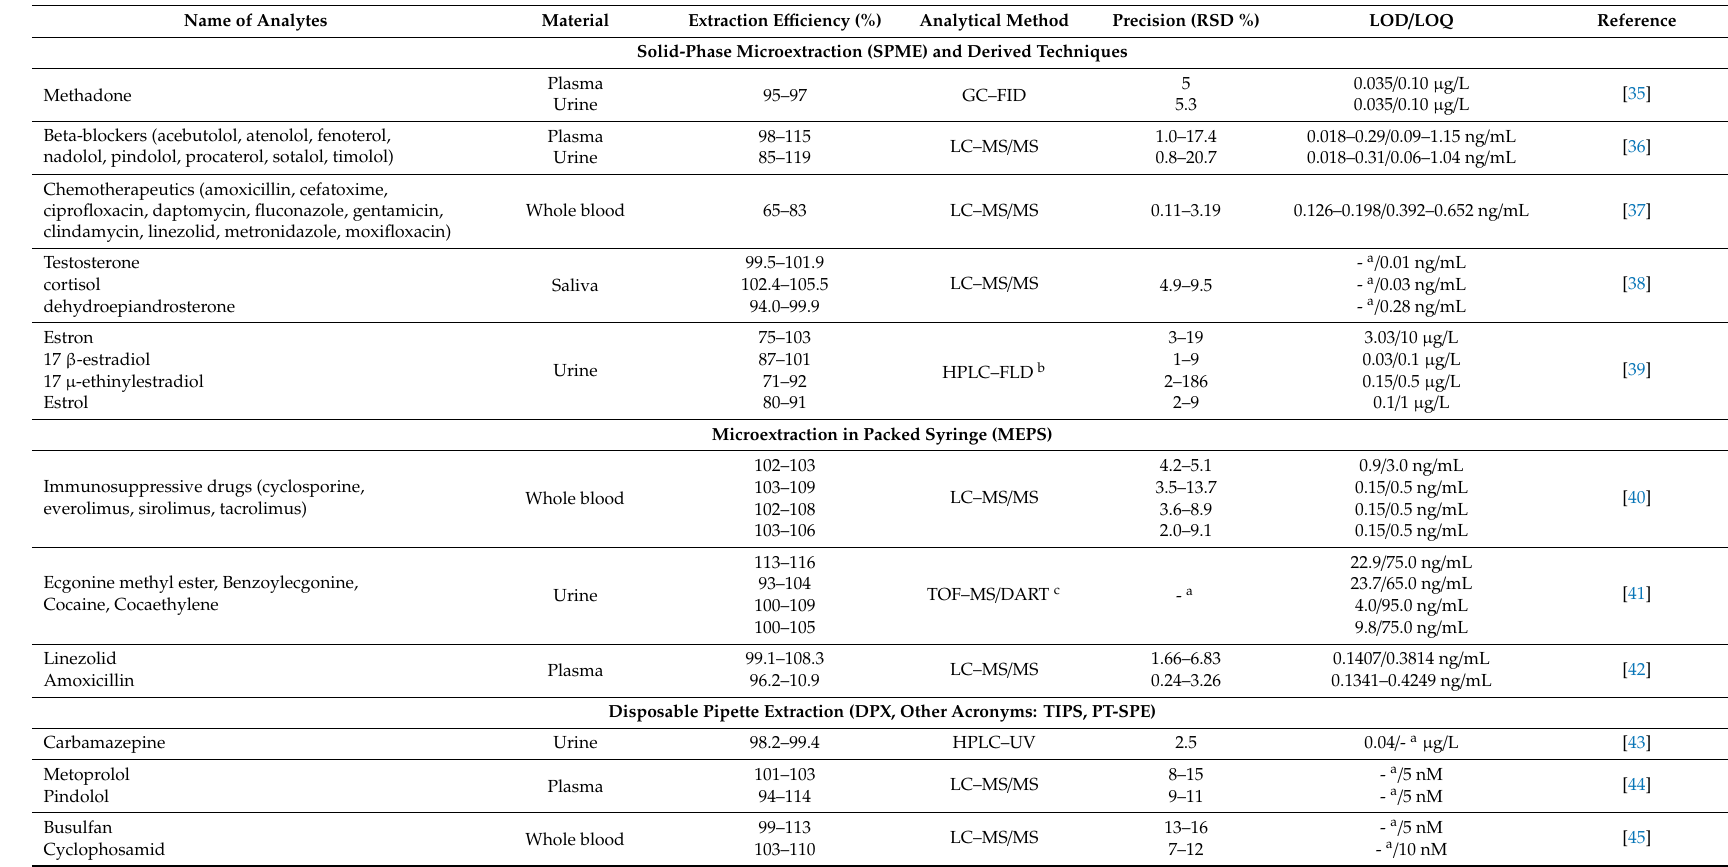
Table 1. Methods of sample preparation by solid-phase